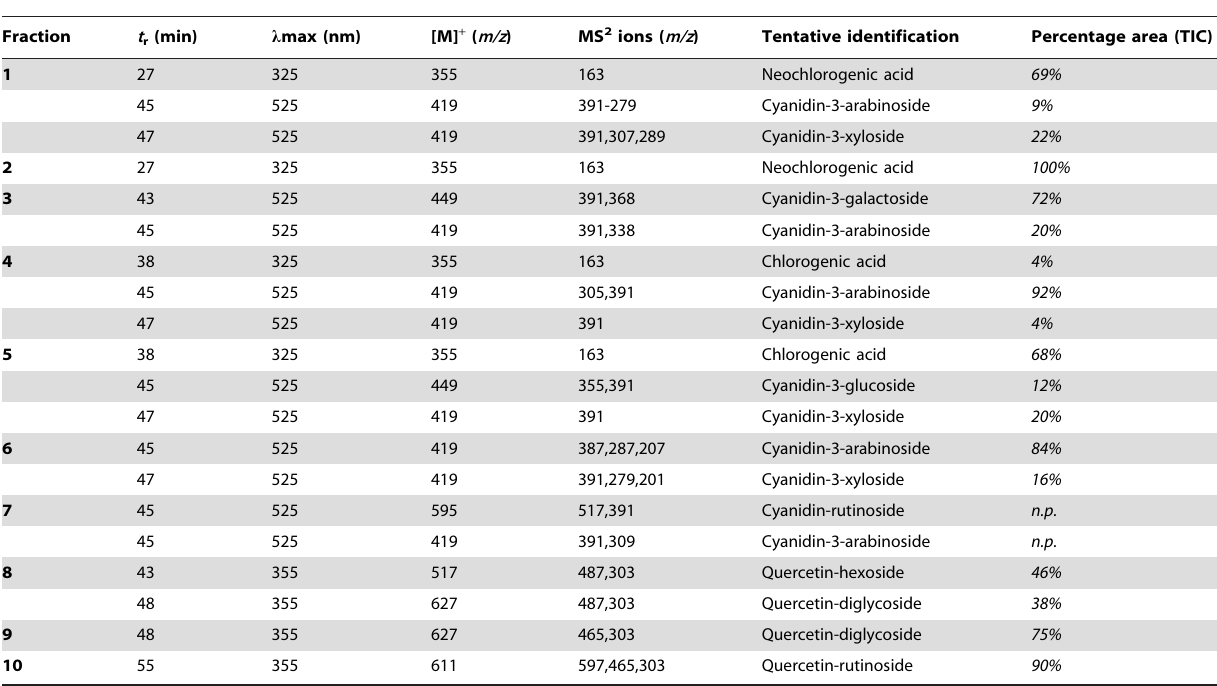
Table 1. Tentative identification of phenolic compounds present in AMJ-derived fractions by HPLC and LC-MS analysis.